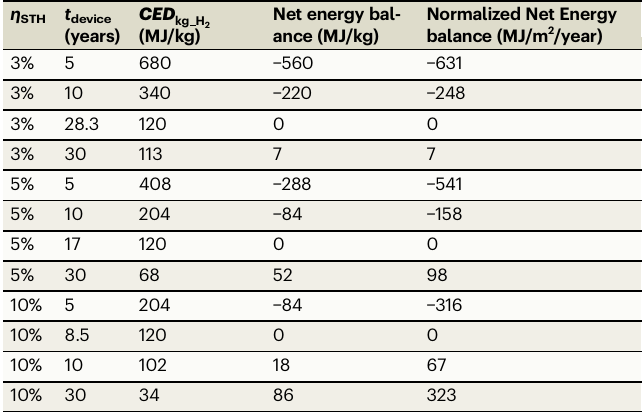
Table 1 | Net energy balance assessment results for PEC devices that produce only H 2 with various assumptions of STH ef fi ciency ( η STH ) and device longevity ( t device